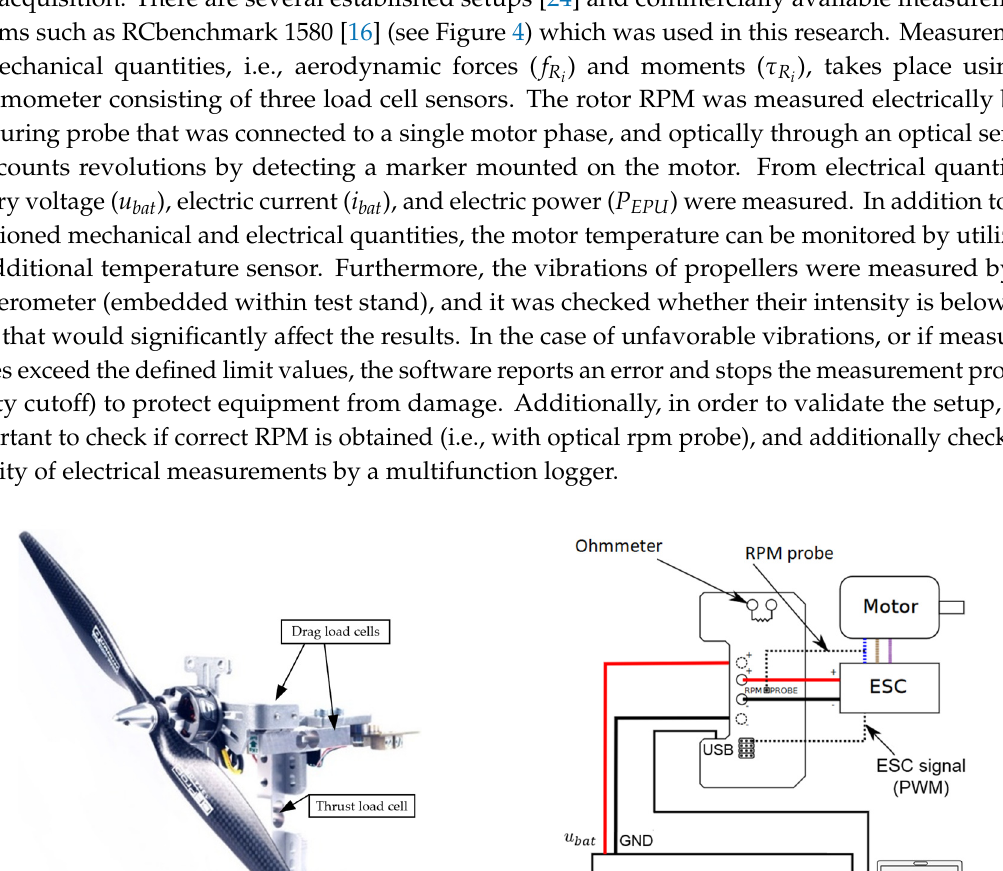
According to the diagram in Figure 4b, ESC, other sensors, and power supply were connected to the setup control board, which connects the PC via USB cable. Prior to the measurements, the dynamometer was calibrated according to the procedure described in the installation documentation [16]. To verify the measurement of electrical quantities and angular velocity of the rotor, a multifunctional logger PowerLog 6S [25] was used. Signal acquisition and data storage in .csv format was performed in the software package that comes with the setup. 3.2. Data Acquisition The throttle signal sent to the ESC drive was a standard 50 Hz PWM signal with “ON” time ranging from 1000 to 2000 μ s (dependent on the ESC). It is possible to send individual PWM signals (manual mode) or send varying signals defined in the RCbenchmark software measurement script (automated mode). Since the goal was to automate and unify measurements, an available script was modified to take four measurements for each PWM value within one measurement cycle. The script is changing the PWM signal from minimal to a maximal value and vice versa in discrete steps, twice. Every PWM signal is held constant for 10 s after which the PWM “ON” time increases or decreases by 100 μ s depending on the step of the measurement cycle. The flowchart of the setup script is shown in Figure 5. Upon completion of the measurement cycle, the .csv file is automatically generated in